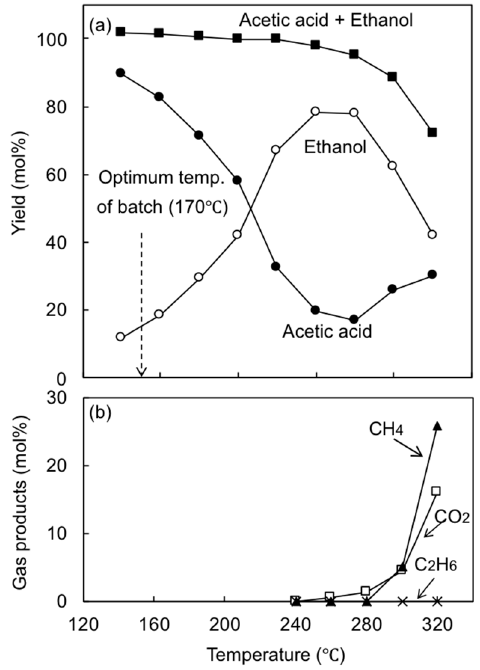
Figure 1. Effect of reaction temperature on hydrogenation of aqueous acetic acid (10 g/L) to ethanol with flow reactor: ( a ) liquid products; ( b ) gaseous products (column size: 3.9-mm inner diameter, 100-mm length; pump flow rate, 0.3 mL/min; H 2 flow rate, 60 mL/min; pressure, 10 MPa).